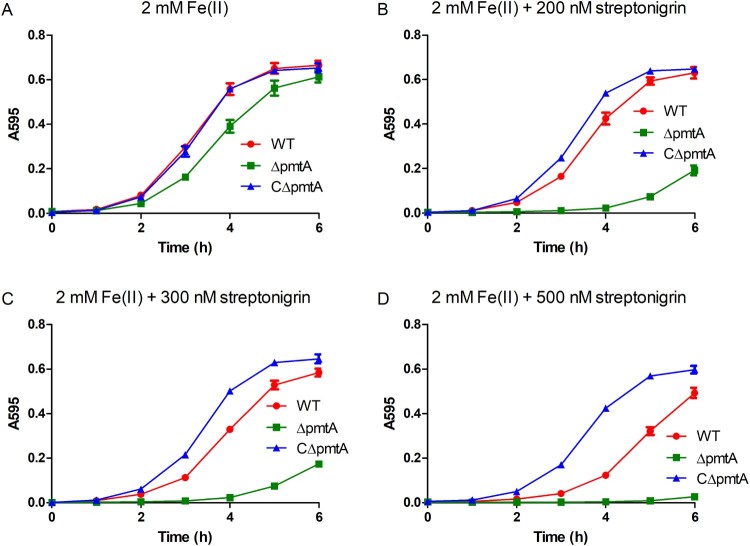
ΔpmtA exhibits increased sensitivity to streptonigrin. The S. suis strains were grown in the presence of 2 mM Fe(II) and increasing concentrations of streptonigrin. (A) No streptonigrin, (B) 200 nM streptonigrin, (C) 300 nM streptonigrin, and (D) 500 nM streptonigrin. Graphs data are mean values ± SD from three wells.